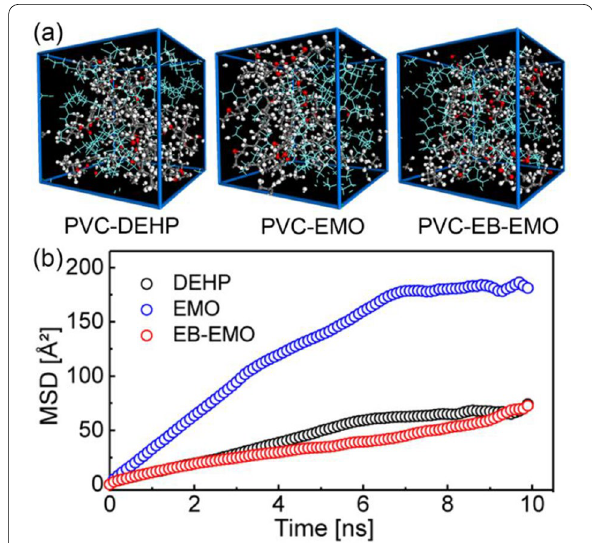
Scheme 7 a PVC amorphous cells containing a fixed number of plasticizer molecules (DEHP: di-(2-ethylhexyl) phthalate; EMO: epoxidized methyl oleate; EB-EMO: ester-branched epoxidized methyl oleate). b MSD of DEHP, EMO and EB-EMO within a